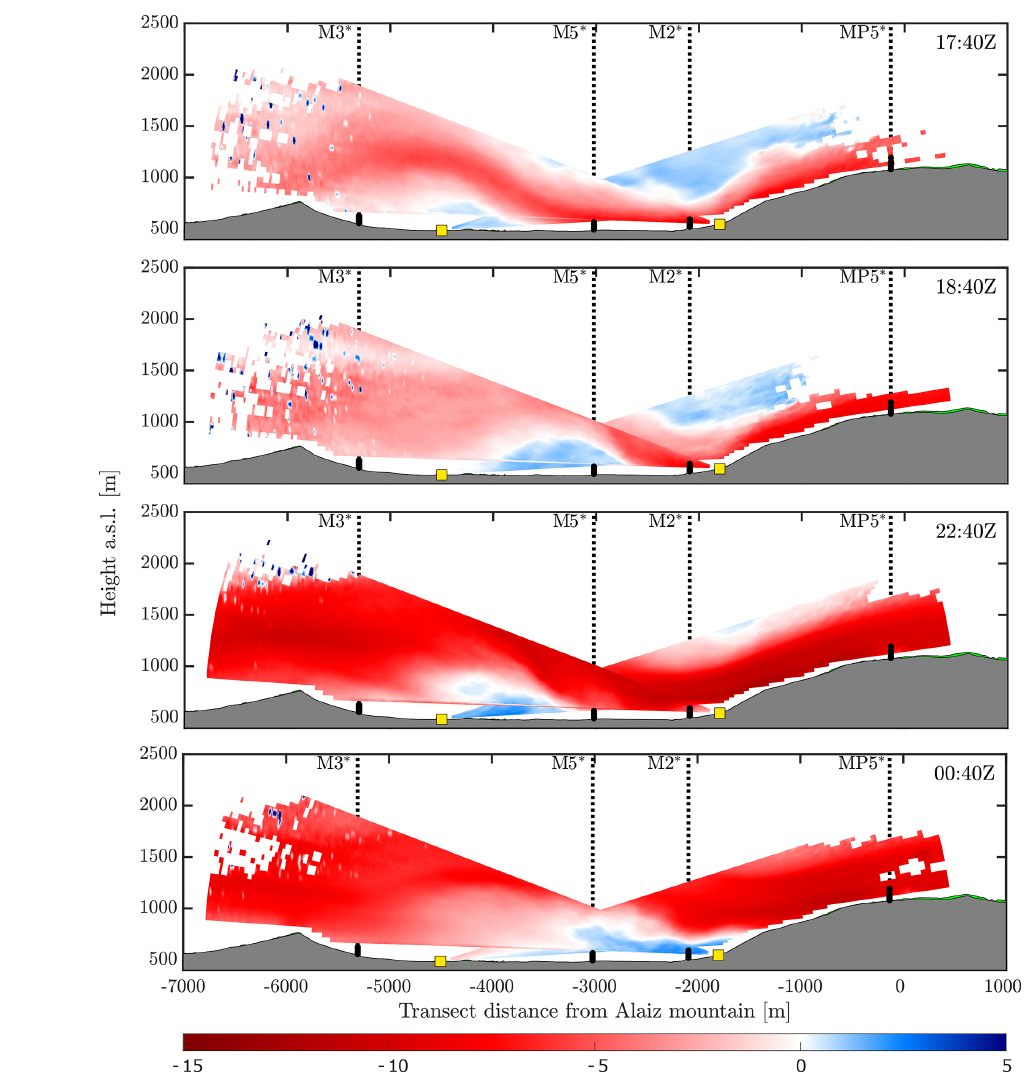
Figure 9. Superposition of dual RHI scans during the hydraulic jump period between 5–6 October 2018. The color bar represents radial wind speed in meters per second (ms − 1 ) with negative values representing flow from right to left. Each of the frames correspond to a 10min